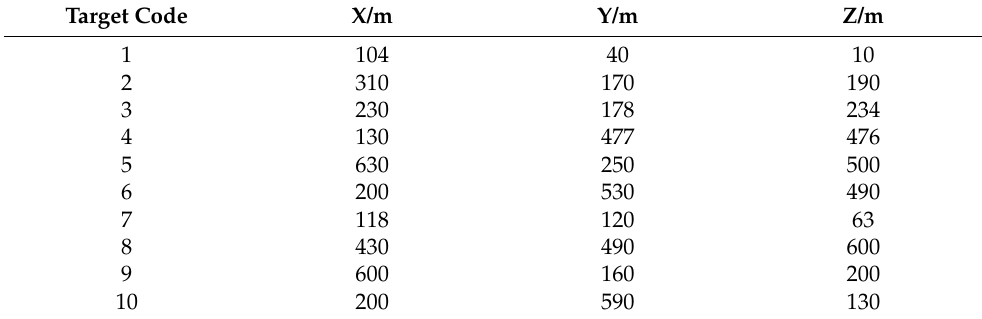
Table 4. Target coordinates.